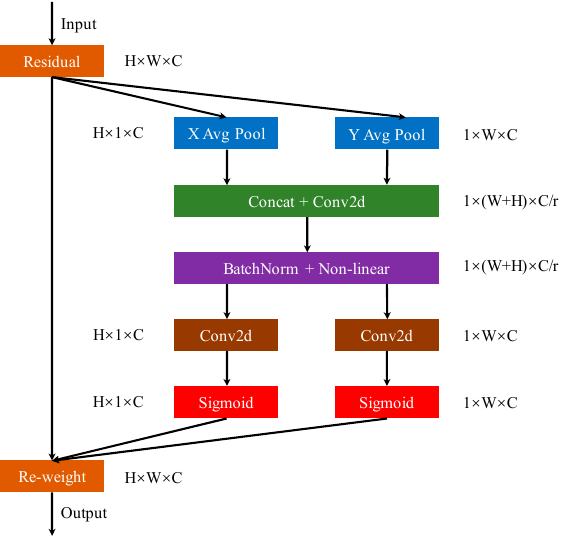
Figure 3. CA module structure. Figure 3. CA module